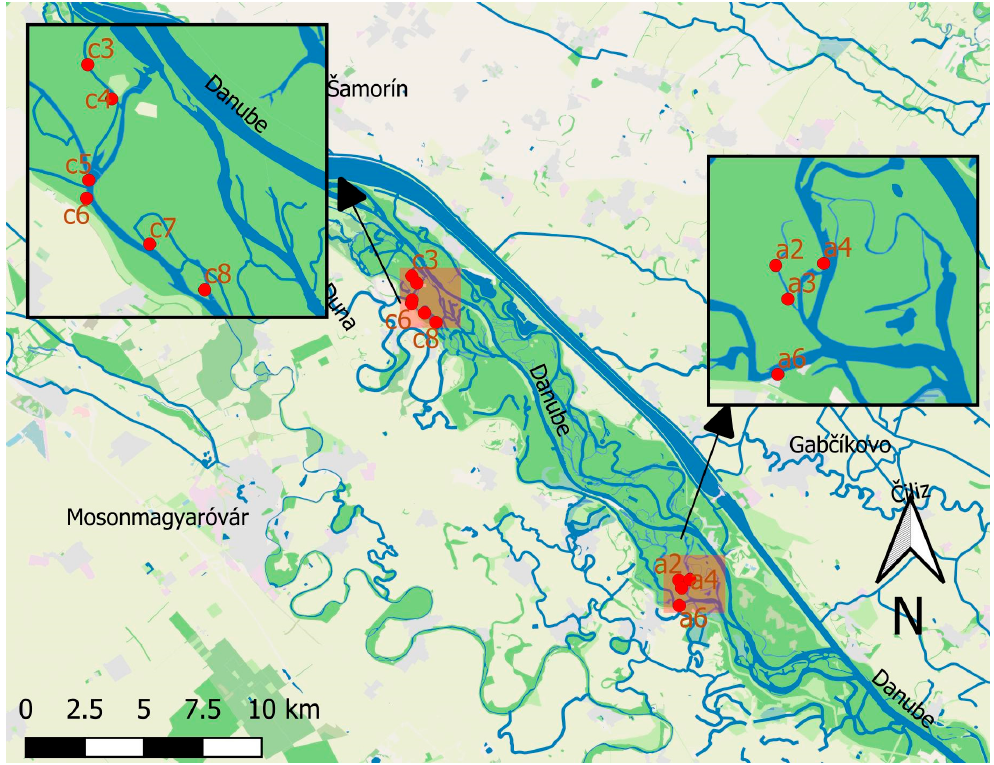
Figure 1. Location of sampling points in the Ásvány (dots marked with a) and Cikola (dots marked with c) tributary systems.